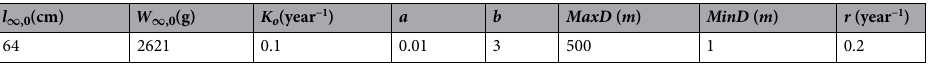
Table 1. Initial parameter values for Homarus americanus . l ∞ = maximum length; W ∞ = maximum weight; K = von Bertalanffy growth parameter K; a = length–weight relationship parameter a; b = length–weight relationship parameter b; MaxD = maximum depth; MinD = minimum depth; r = intrinsic population growth